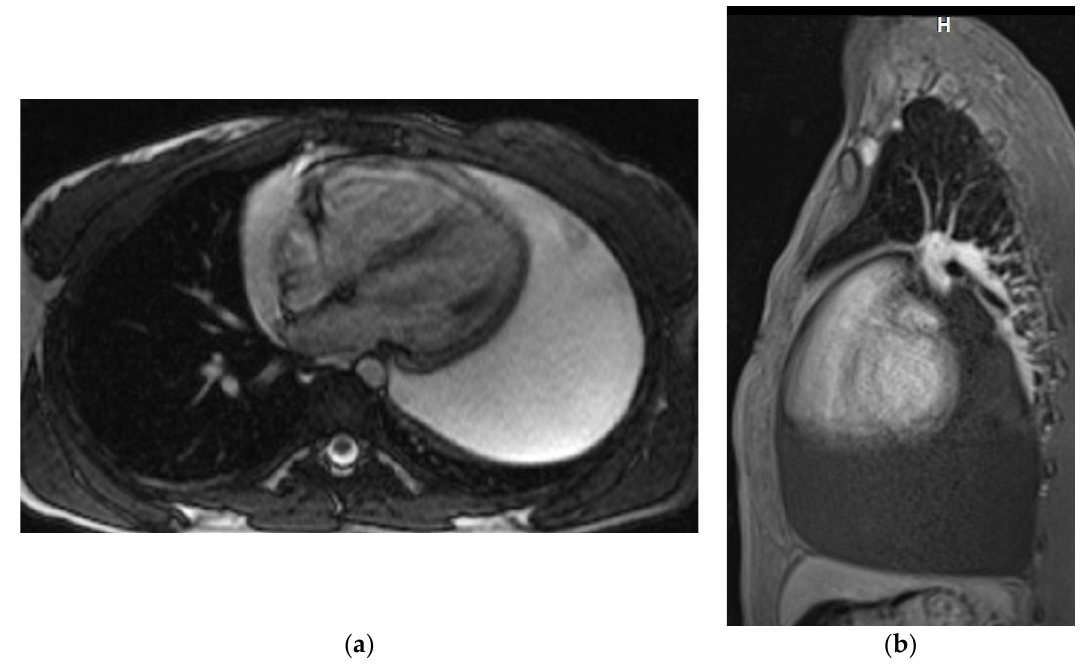
Figure 3. Chest MRI. T2-weighted image, axial view ( a ) T1 weighted image with fat saturation and with contrast enhancement, sagittal view ( b ). Large pericardial effusion is seen, hyperintense on T2-weighted image ( a ) and hypointense on a T1-weighted image ( b ).